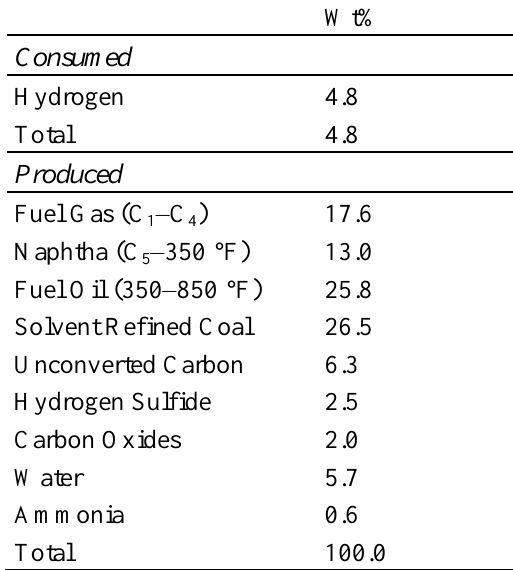
Table 11. Process yields for SRC II process for Kentucky Bituminous